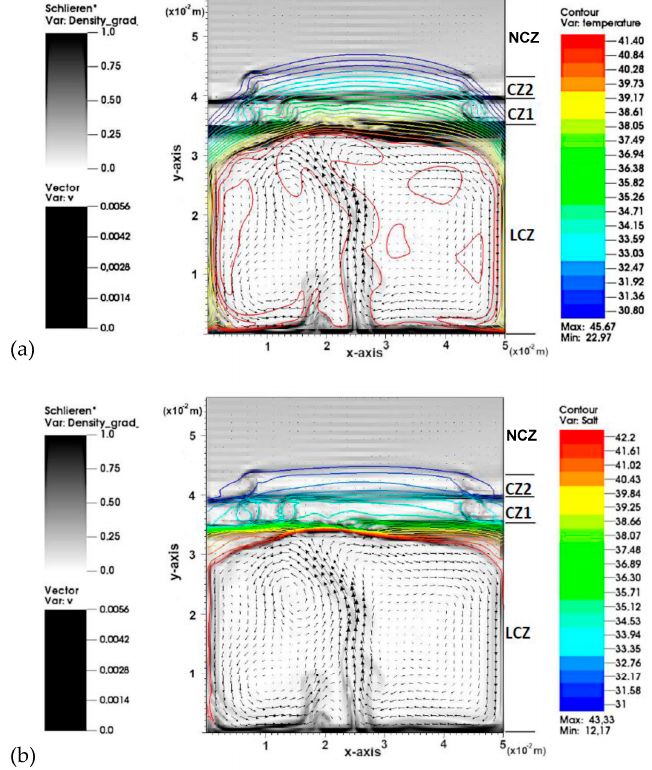
Figure 7. Schlieren image at t = 2470 s overlayed with the predicted velocity field and ( a ) temperature contours or ( b ) salinity contours. The temporal evolution of the temperature and salinity at different depths is plotted in Figure 10 where z stands for the depth, i.e., the distance from the top surface to the horizontal plane under consideration. The temperature and salinity at a given z represent the average temperature and salinity, respectively, at that z location and at the time under consideration. The temperature increases at depths greater than or equal to 4 cm until a peak is attained. At a later time, the temperature decreases, and its evolution is identical to that observed at greater depths, i.e., the temperature is uniform at depths greater than that under consideration, which corresponds to the LCZ. In fact, the temperature in the LCZ is approximately uniform, except in the close vicinity of the walls, as illustrated in Figures 5–8. At a depth of 3 cm, the evolution is similar to that observed at higher depths, except that there is a decrease between 4.5 and 5 h. At lower depths, the temperatures tend towards that observed at the top surface because the temperature is approximately uni- form in the UCZ, except in the region close to the walls.